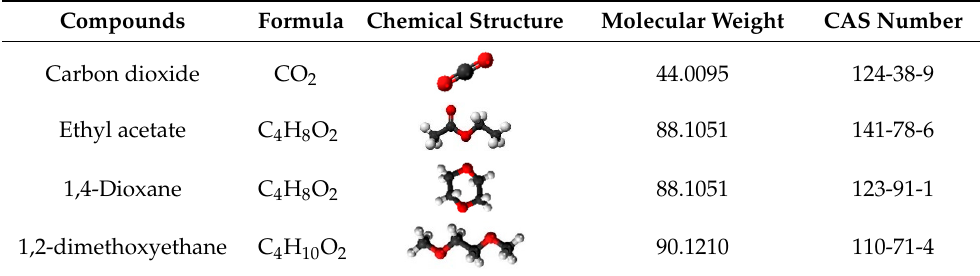
Table 1. Compound structures and molecular mass.